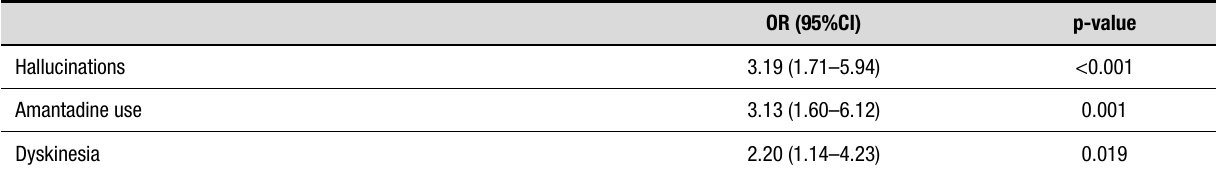
Table 4. Multivariate logistic regression model.